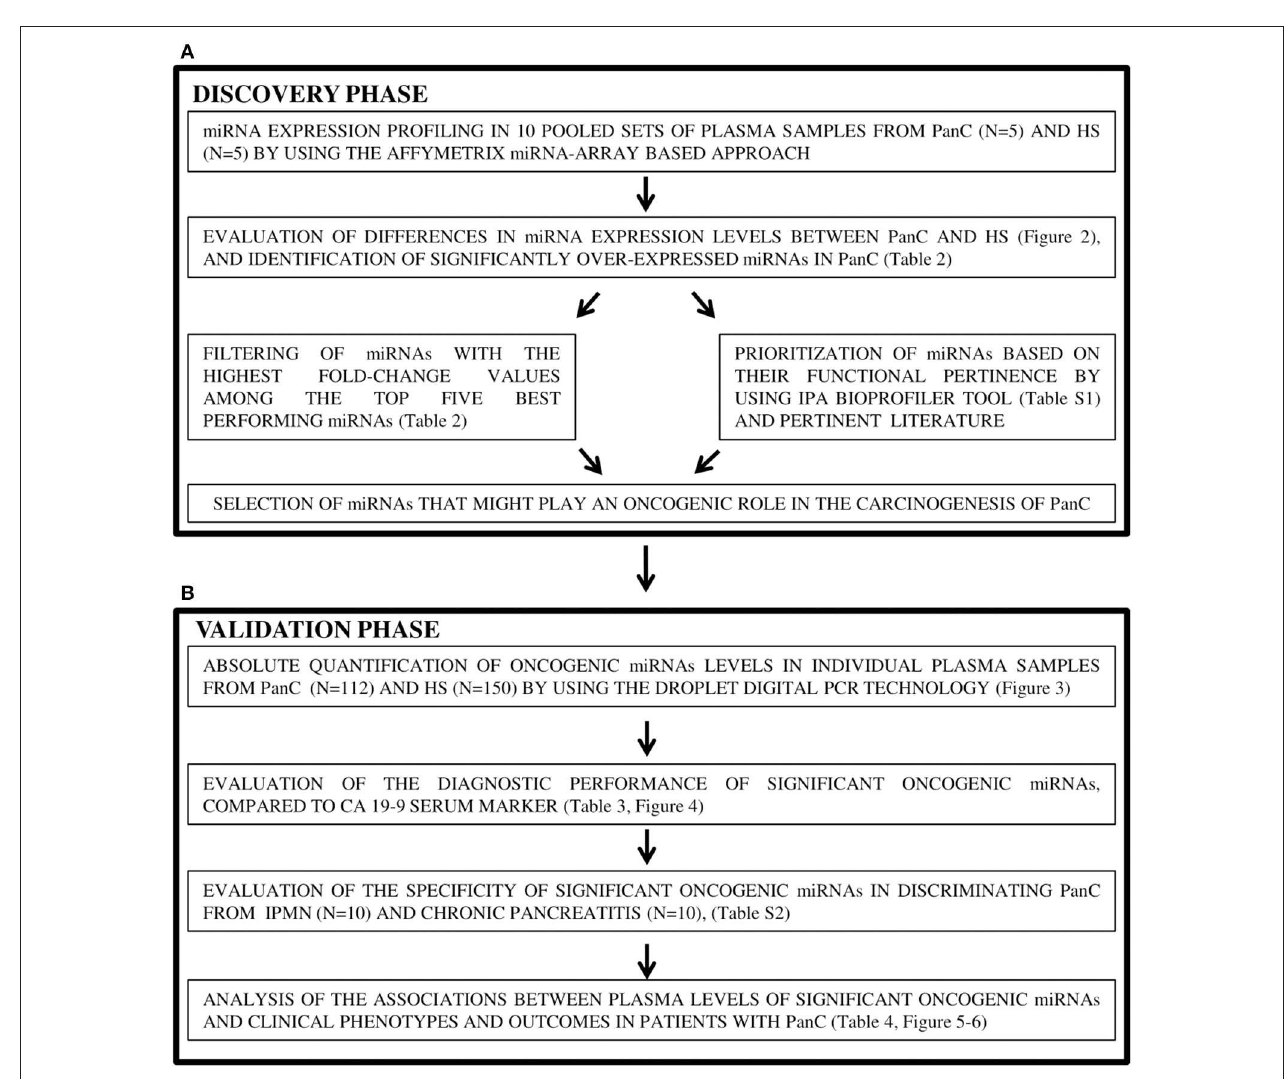
FIGURE 1 | Study design of the two-stage process for the identification (A) and validation (B) of candidate oncogenic miRNAs in pancreatic cancer. PanC, pancreatic cancer; HS, Healthy